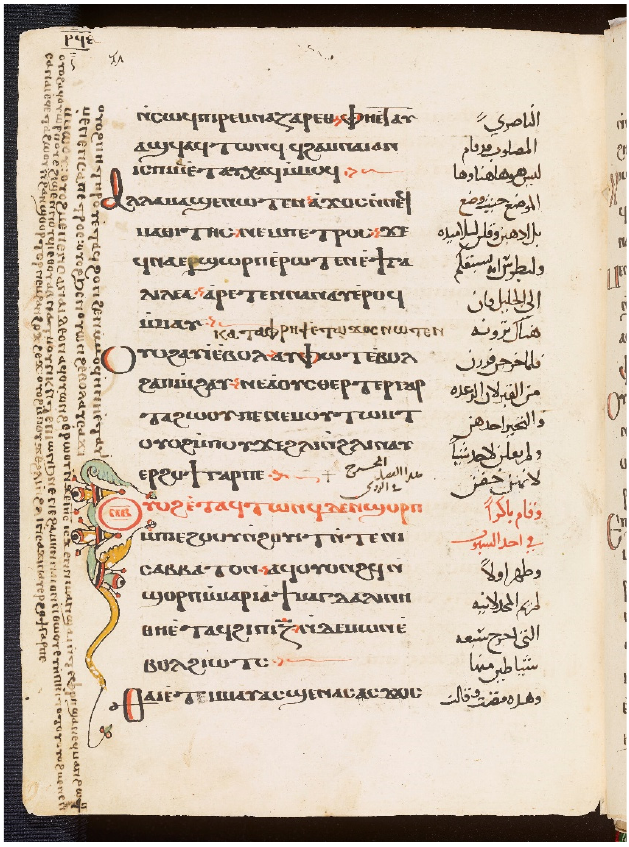
Figure 2. Huntington 17 (bo 2) f. 194 v . Copyright © Digital Bodleian Creative Commons license CC-BY-NC 4.0.